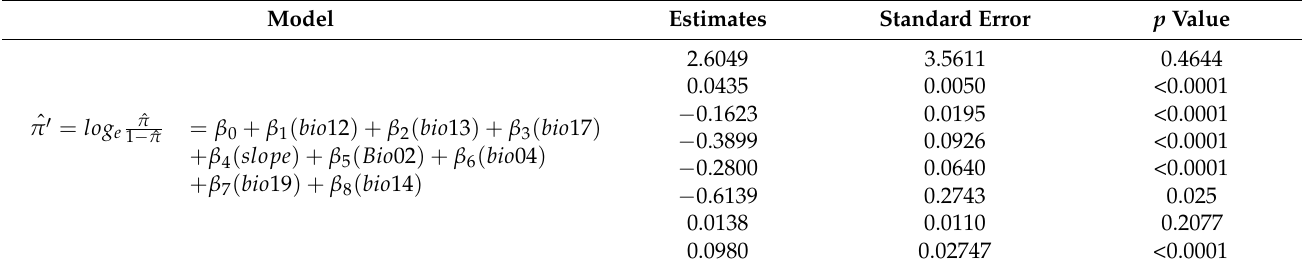
Table 5. Parameters for modelling potential distribution using the GML approach.